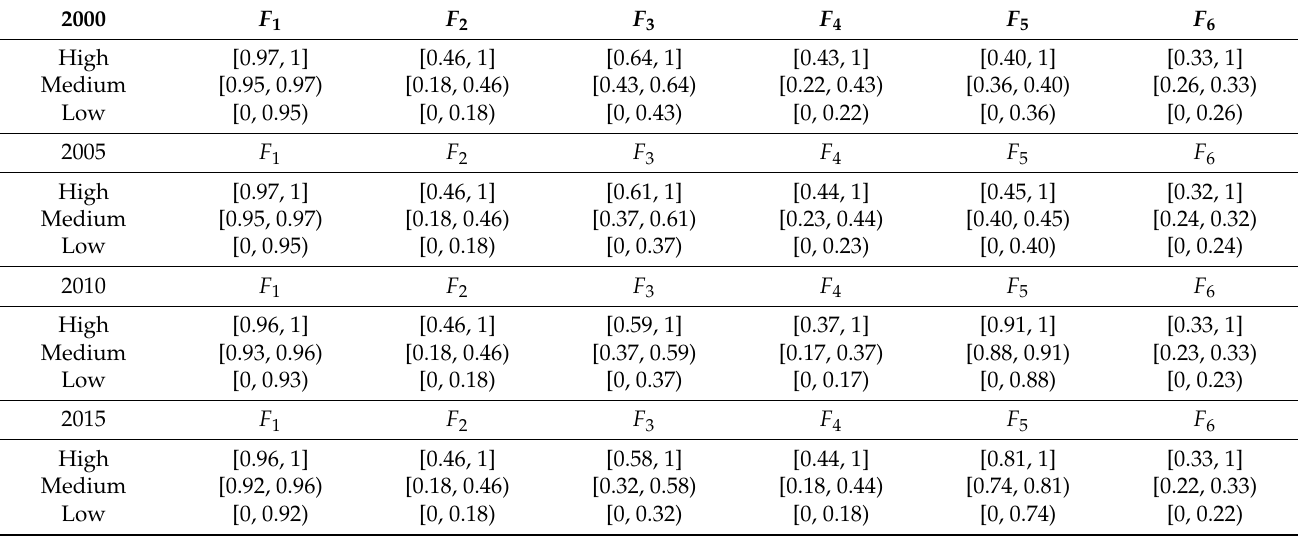
Table A2. The interval value of each PDF classified according to the natural break